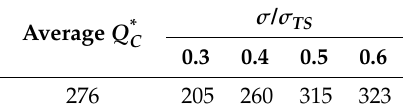
Figure 1. Determination of Q ∗ using the traditional Arrhenius plot approach: ( a ) time to rupture as a function of the ratio of test stress to ultimate tensile strength; ( b ) Arrhenius plot of the natural log of time to rupture vs. the inverse absolute temperature. Table 1. Calculated Q ∗ values (kJ/mol) at each stress Average C 0.3 ∗ 𝝈𝝈 𝝈𝝈 𝑻𝑻𝑻𝑻 ⁄ 𝑸𝑸 𝑪𝑪